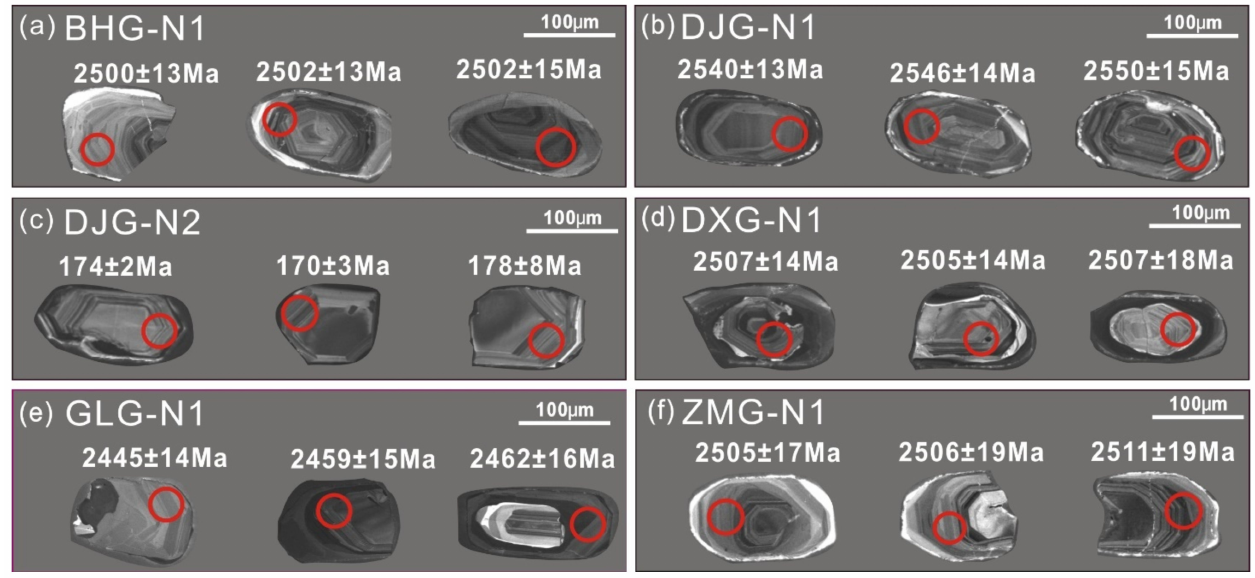
Figure 5. Cathodoluminescence (CL) images of represented analyzed zircons from the TTG gneisses and diorite samples in the Liuhe